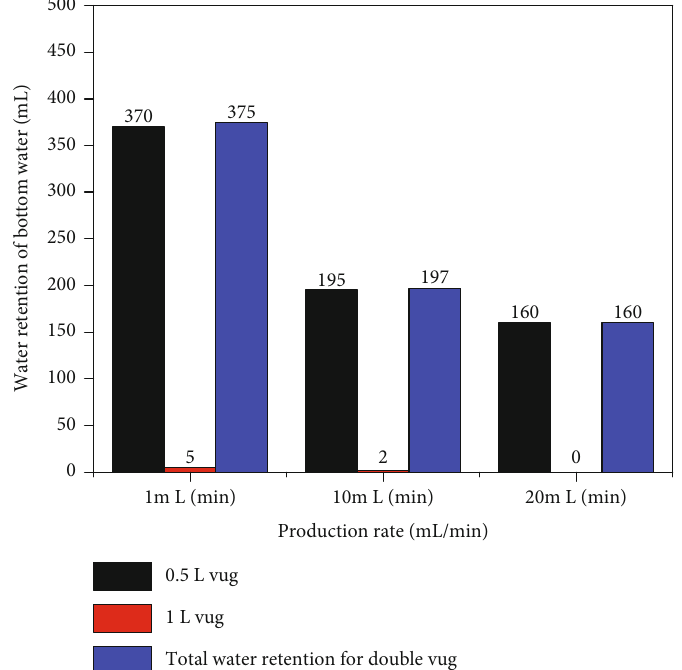
Figure 22: Column chart of bottom water invasion and retention in high-pressure physical property experiments under connection type II (di ff erent production